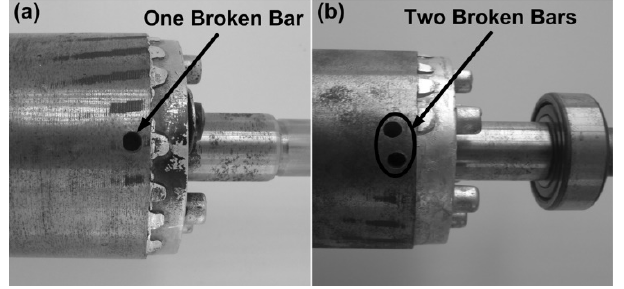
Figure 3. Motor conditions.